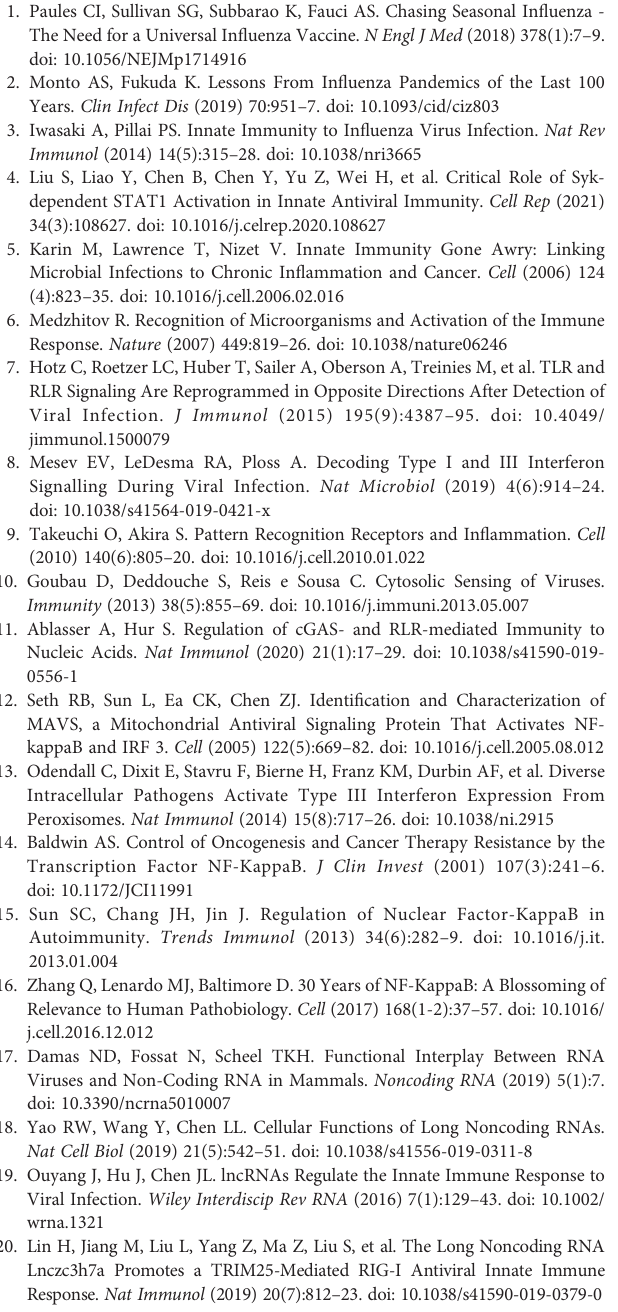
Supplementary Figure 7 | RDUR interacts with ILF2 and ILF3 RNA binding proteins. A549 cell lines stably expressing speci fi c shRNAs targeting ILF3 and